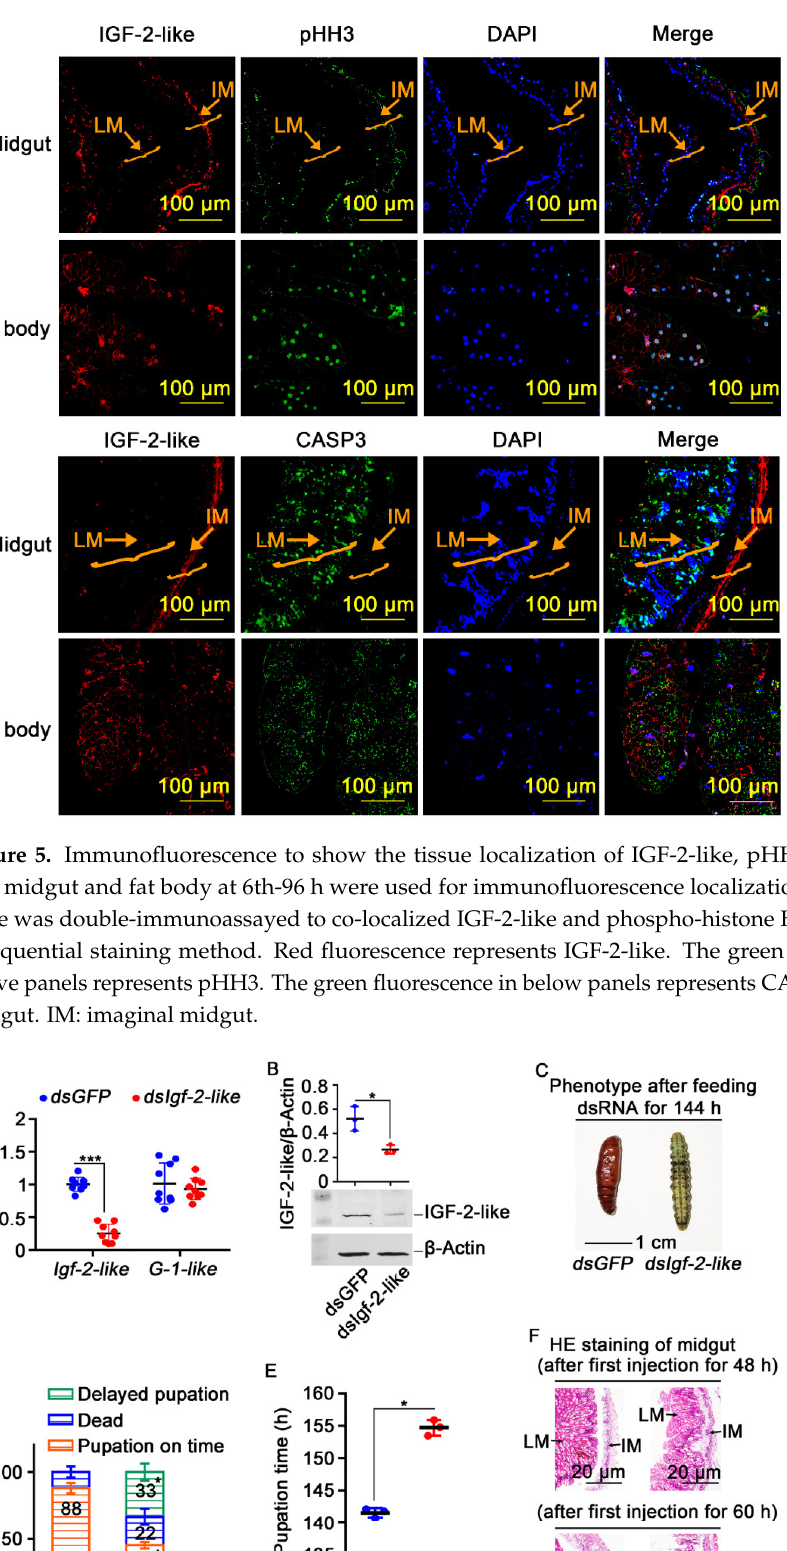
Figure 6. Knockdown Igf-2-like caused delayed pupation. ( A ) Detection of the knockdown efficiency of dsIgf-2-like by feeding the E. coli ; the off-target effect was detected by G-1-like . ( B ) The fat body protein was extracted at 6th-126 h to detect the knockdown efficiency after Igf-2-like knockdown by injection of dsRNA. β-ACTB was used as an internal reference protein. Image J was used to calculate the ratio of IGF-2-like and β-ACTB band densities. ( C ) The phenotype of larvae 144 h after feeding of dsIgf-2-like and dsGFP . ( D ) Statistical analysis of the phenotype. The data for the phenotype ratio were collected in triplicate using thirty larvae each time by feeding the E. coli . The delayed pupation was defined as a pupation time longer than the average pupation time of the dsGFP (142 h) group by feeding the E. coli . ( E ) The pupation time by feeding the E. coli . ( F ) HE staining of the midgut after the injection of dsIgf-2-like and dsGFP for 48 h and 60 h. ( G ) Morphology of the fat body after the first injection for 10 d and 11 d by injection of dsRNA. ( H ) The expression levels of Wnt and c- Myc in the fat body were detected after Igf-2-like knockdown by injection of dsRNA. All the experiments comprised three biological repetitions. The error bar indicates the mean ± SD, and a t - test was used to show significant differences (* p < 0.05, *** p < 0.001). 4. Discussion We identified and revealed that the expression of IGF-2-like upon 20E stimulus is upregulated in the imaginal midgut and fat body cells during metamorphosis. IGF-2-like plays key roles to maintain the growth and proliferation of imaginal midgut and fat body cells. Interestingly, IGF-2-like-positive fat body cells did not undergo apoptosis and were identified as the progenitors of the adult fat body.